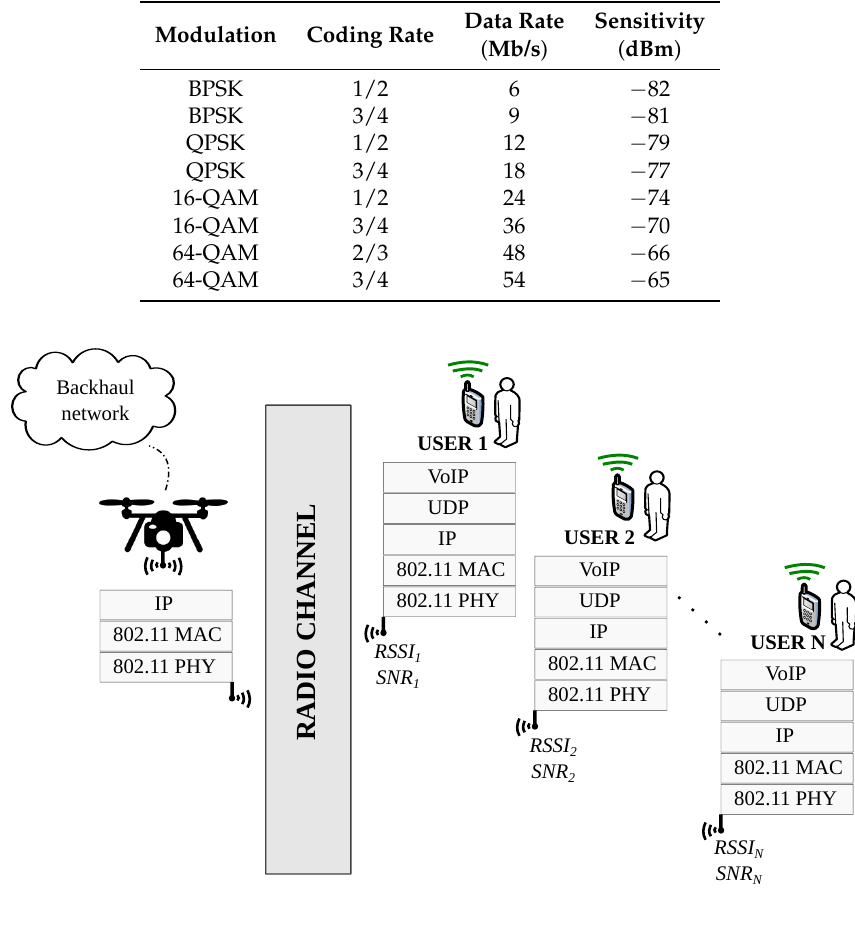
Figure 2. Communication system for each